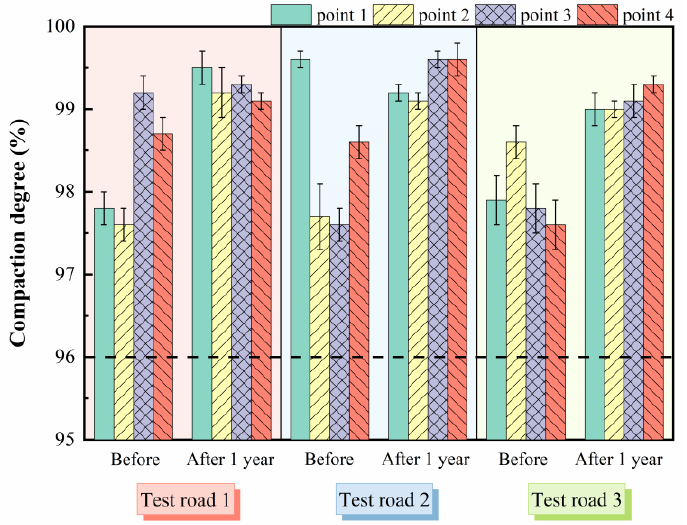
Figure 12. Compaction degree test results before and after operation of the test roads.